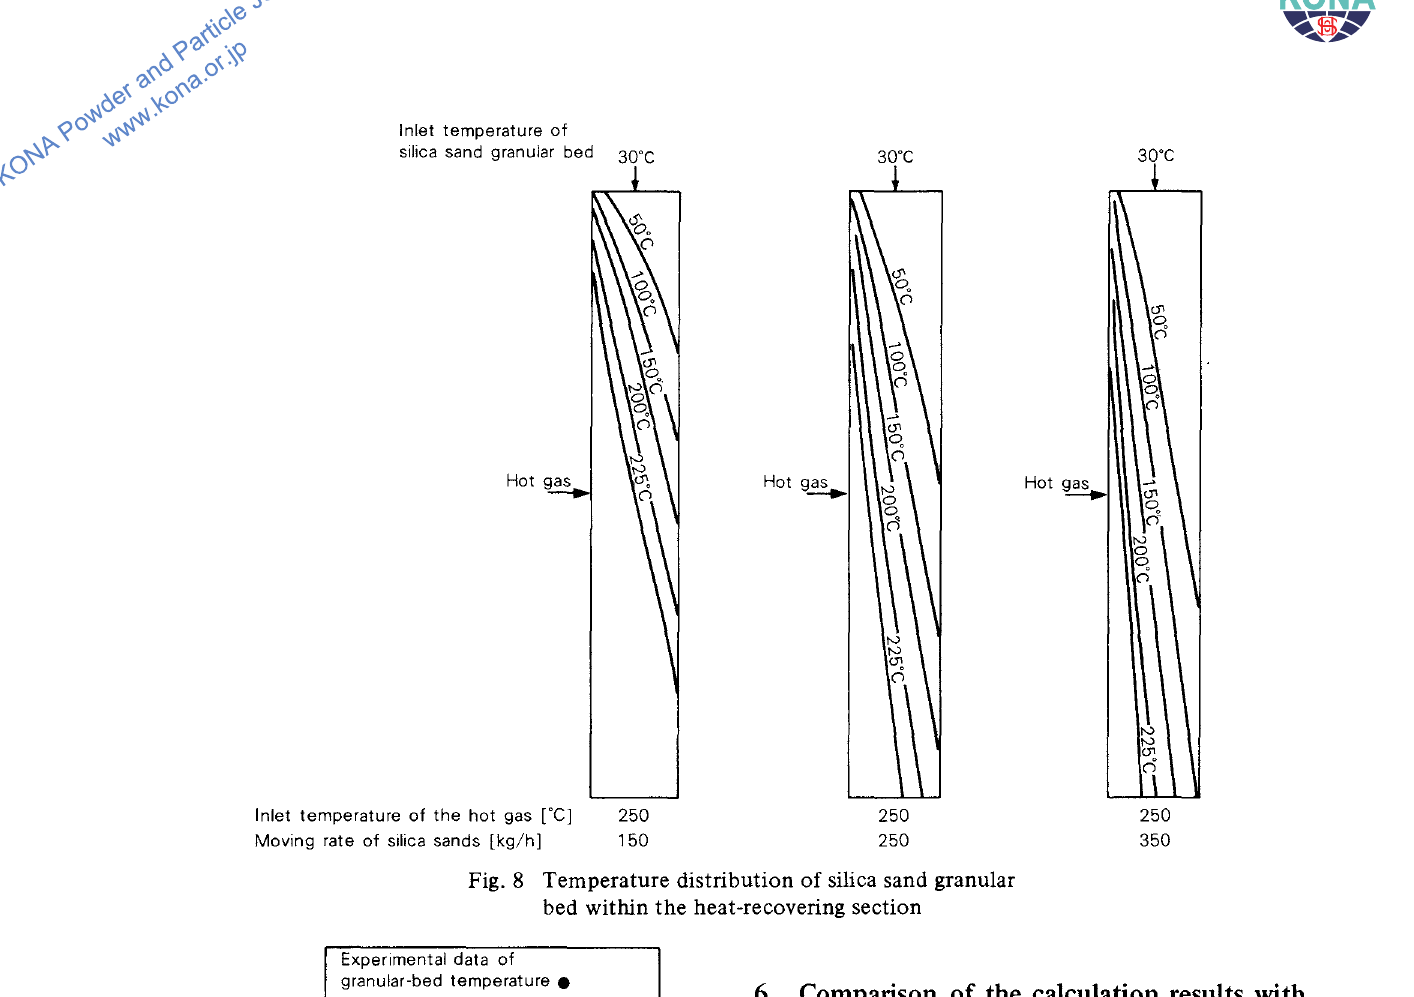
Fig. 8 Temperature distribution of silica sand granular bed within the heat-recovering section